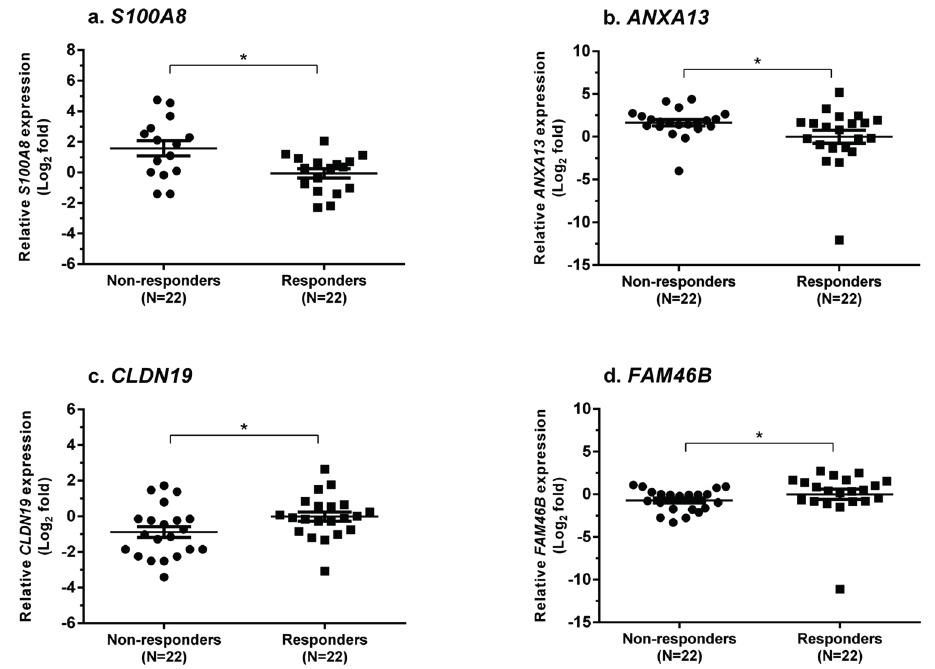
Figure 2. Dot-plots showing the relative gene expression levels between the LN responder and non-responder groups. The selected genes showing upregulation of gene expression were ( a ) S100A8 and ( b ) ANXA13 , while those showing downregulation of gene expression were ( c ) CLDN19 and ( d ) FAM46B . * p <